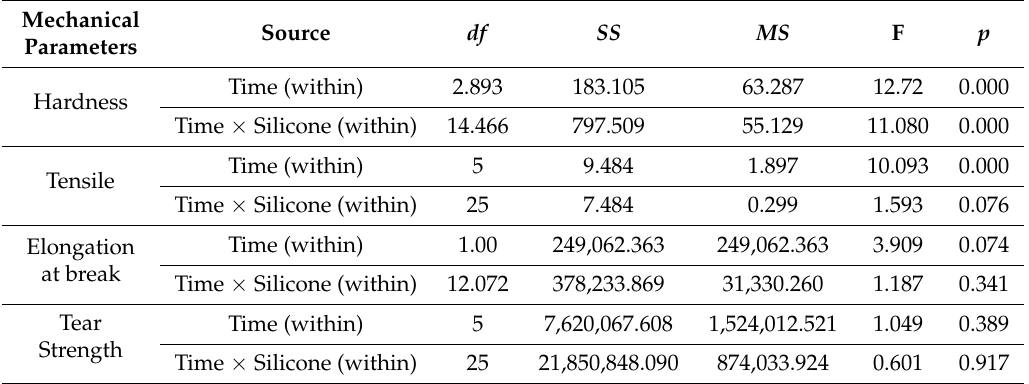
Table 2. ANOVA table for mechanical parameters in this